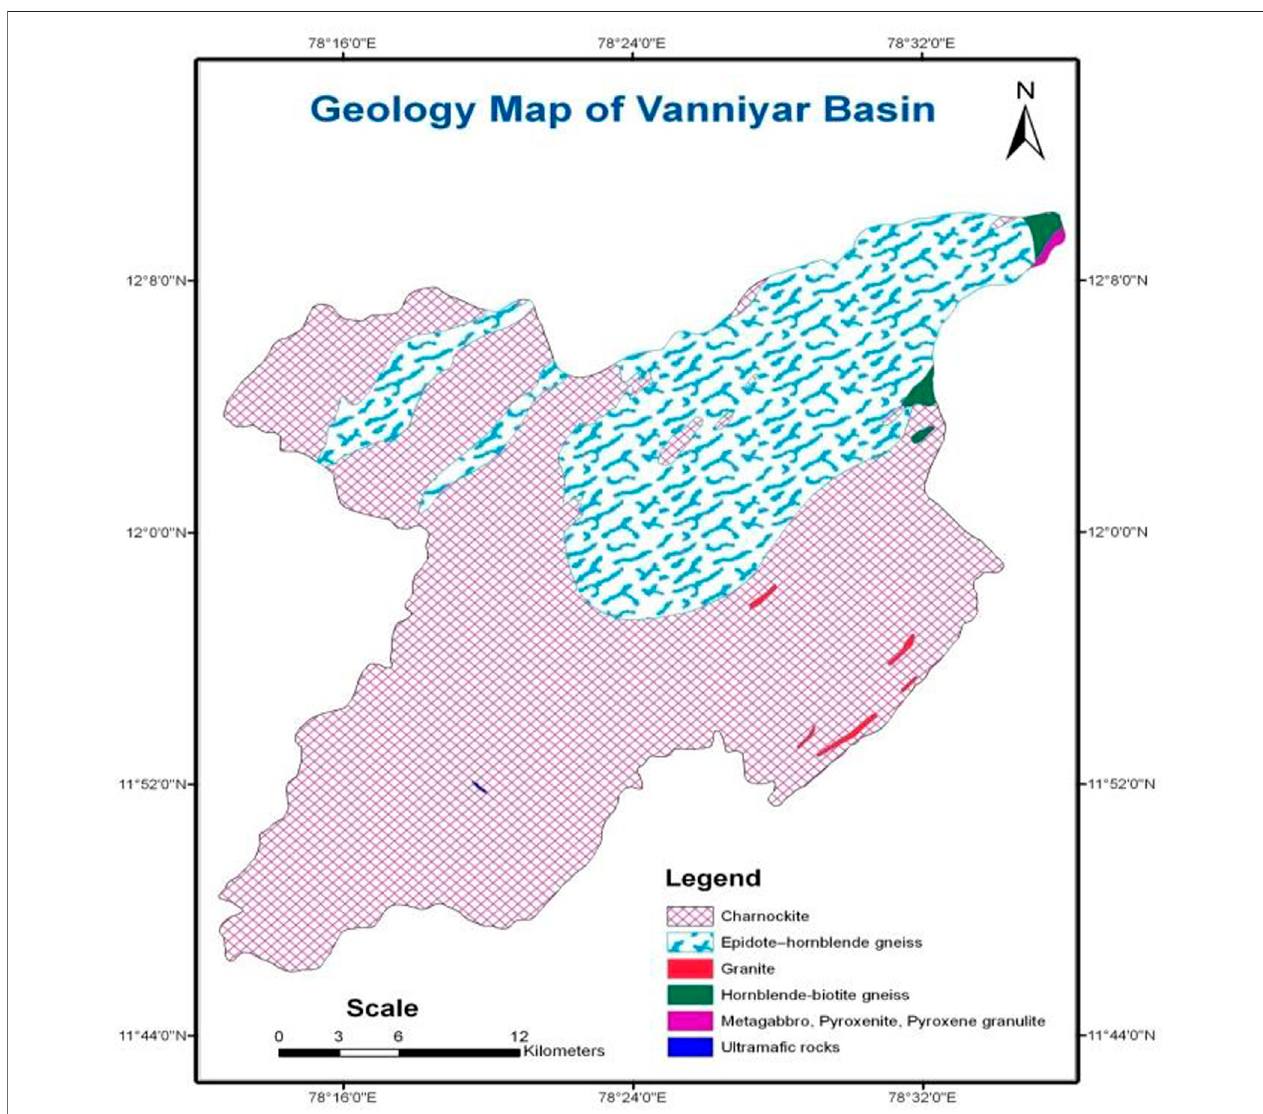
FIGURE 3 | Geological characteristics of the Vanniyar basin, Dharmapuri district, Tamil Nadu, India.